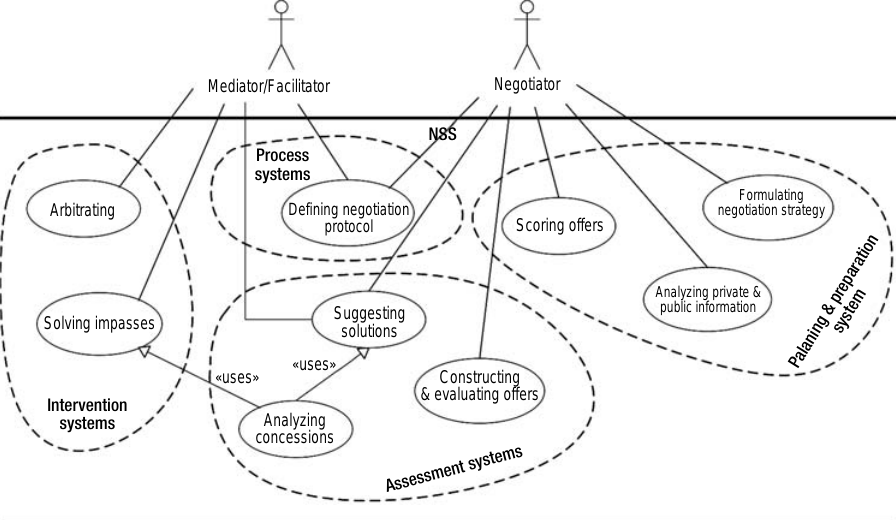
Fig. 1. NSSs and their